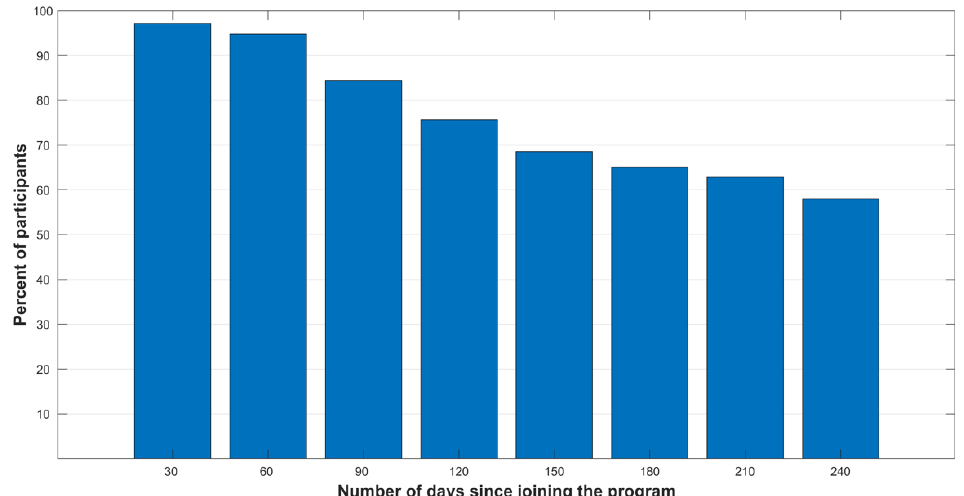
Figure 2. Program retention rates at 30-day time intervals. Y-axis displays the fraction of individuals retained at each time point since joining the program.